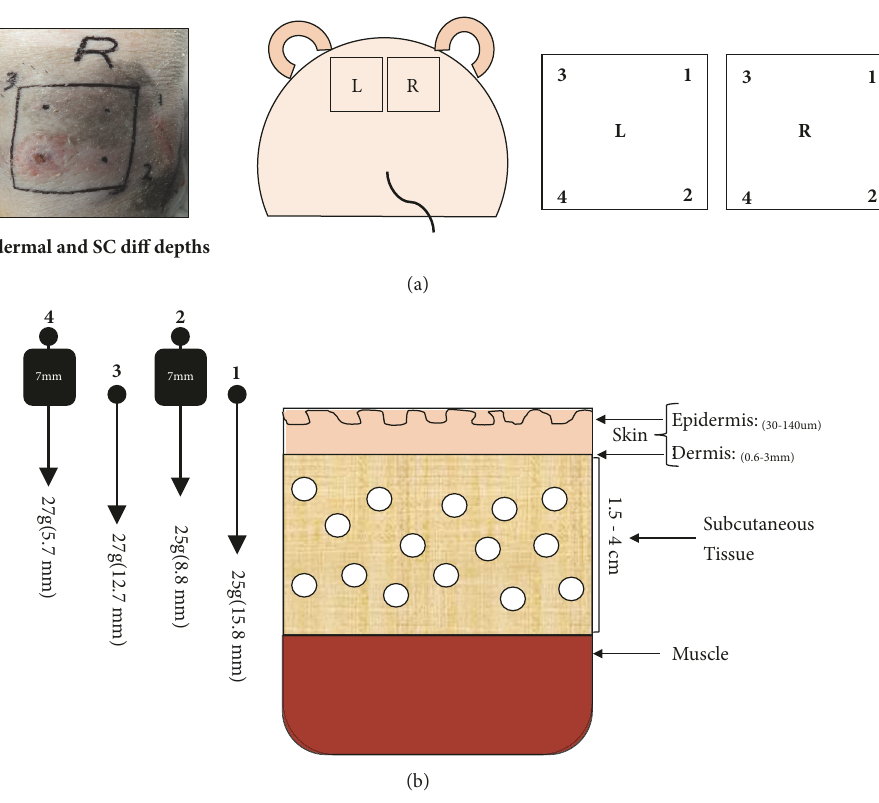
Figure 3: Schematic and real picture representation of the injection sites utilized for CFA administration (a). Schematic representation of the skin layers and thickness to depict the different injections depths used in this model